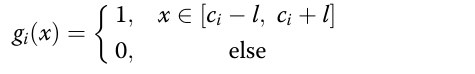
algorithm 24 , simulated annealing algorithm 25 , etc. Com- pared with the conventional transmission matrix